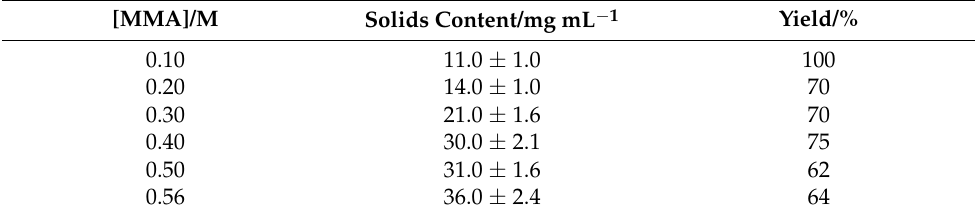
Table 1. Effect of methyl methacrylate concentration MMA on the solids content (mg/mL) and on the yield of the conversion of MMA into poly (methyl methacrylate) (PMMA). The dispersions of PMMA, dioctadecyl dimethylammonium bromide (DODAB) and polydiallyldimethylammonium bromide (PDDA) as PMMA/DODAB/PDDA nanoparticles (NPs) were synthesized using 1.5 mM of DODAB, 5 mg/mL of PDDA, and 0.0036 g azobisisobutyronitrile (AIBN). The data refer to samples just after synthesis and before